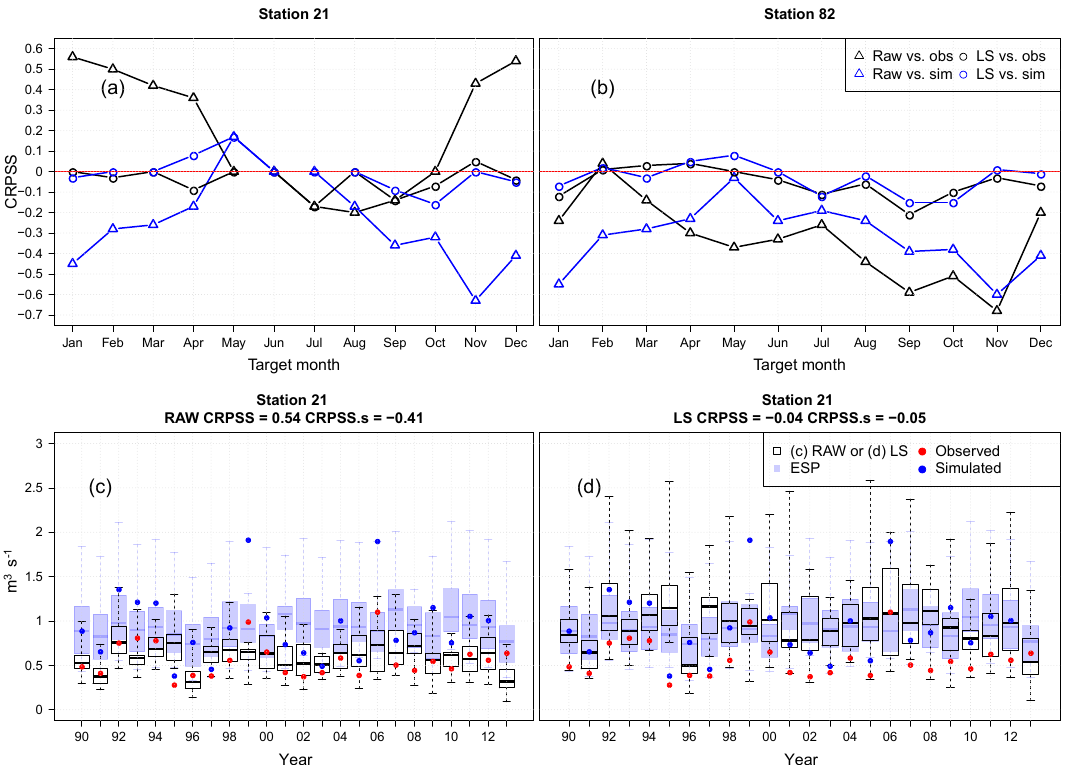
Figure 9. (a, b) Skill of accuracy (CRPSS) for upstream station 21 and outlet station 82 for target months January–December at a lead time of 4. Triangles and circles represent the forecasts generated using raw ECMWF System 4 forcings and preprocessed with LS, respectively, whereas black and blue lines represent the comparison against observed and simulated streamflow, respectively. The second row shows the monthly forecasts of December streamflow initialized in September (4-month lead time) for predictions using raw (c) and preprocessed (d) forcings for all years in the record (1990–2013) for station